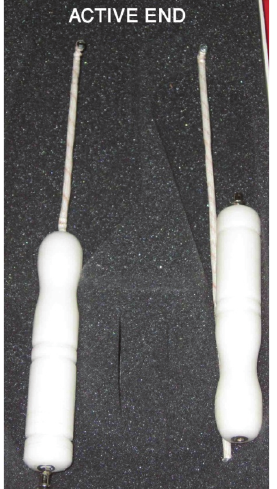
Figure 1: The tactile electrosurgical ablation (TEA)